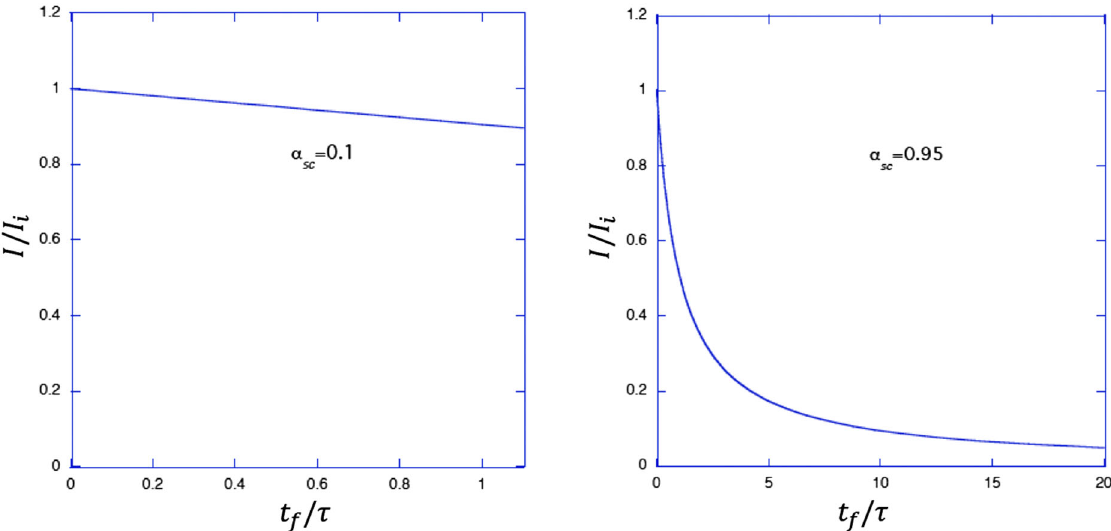
) as a function of final time t i